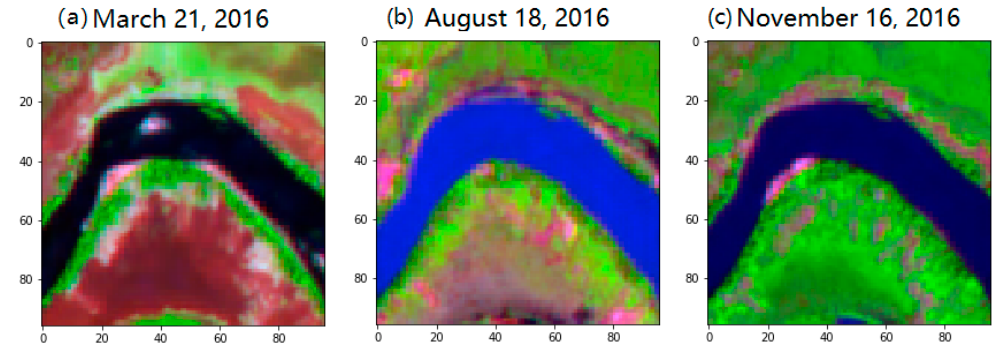
Figure 1. Different representation of RSIR from same location among times: ( a ) March 21, 2016, ( b ) August 18, 2016, ( c ) November 16, 2016.